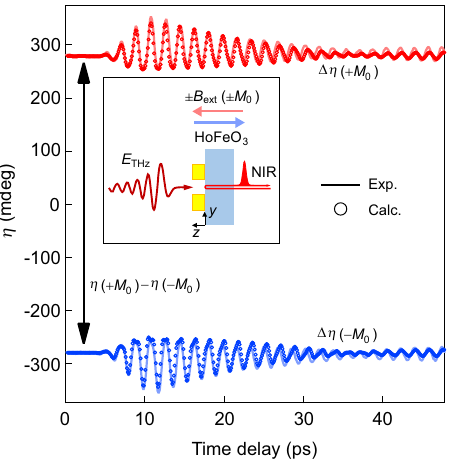
Fig.2|DependenceoftheFaradayellipticityangleontheinitialmagnetization direction. The red and blue curves are the Faraday ellipticity angles measured using an initial magnetization of + M 0 and – M 0 , respectively. The circles are the corresponding calculation results. The calculations are consistent with the experimentaldata,whichindicatesthatnotonlythedynamic Δ η butalsothestatic value η (+ M 0 ) − η ( − M 0 )canbereproducedbyourcalculation.Intheexperiments,the initial magnetization (± M 0 ) was switched by applying an external static magnetic fi eld (± B ext